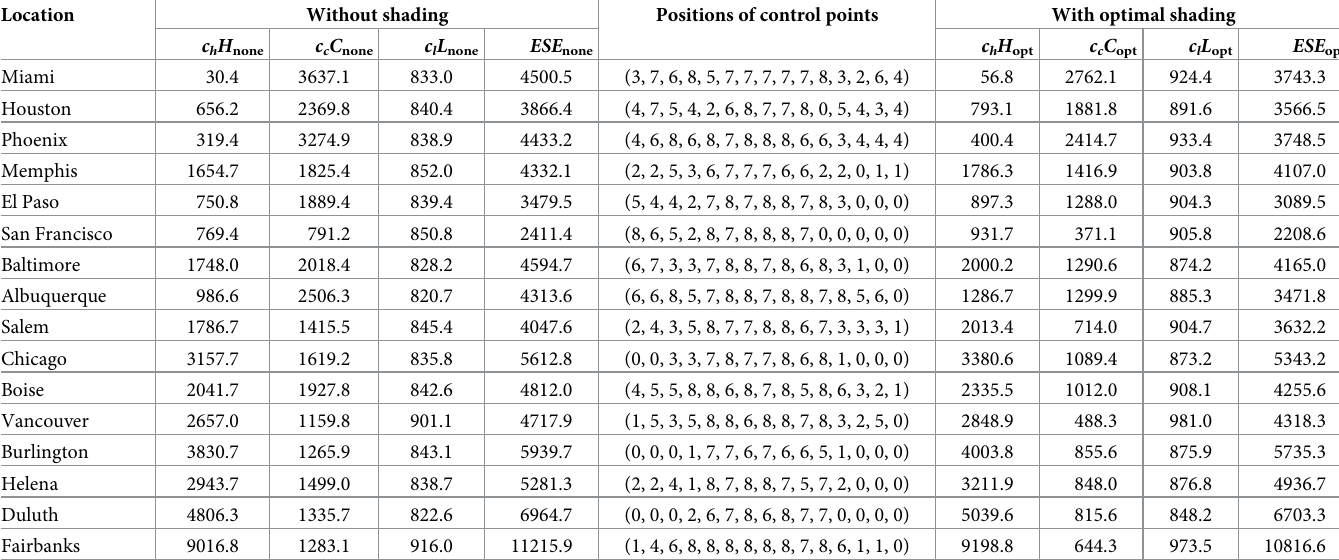
Table 4. Positions of control points in optimal shading found for each location.